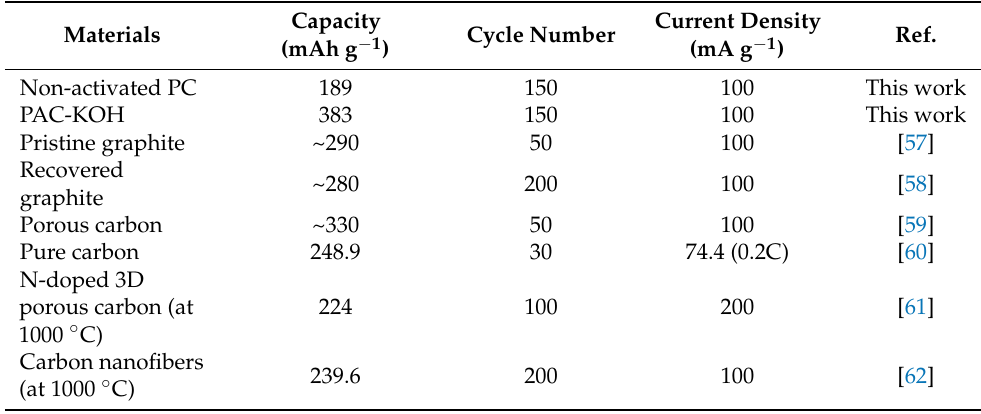
Table 2. Comparison of cycle performance of the PAC products in this work, graphite, other carbonaceous-based materials, and other biomass/biowaste-derived activated